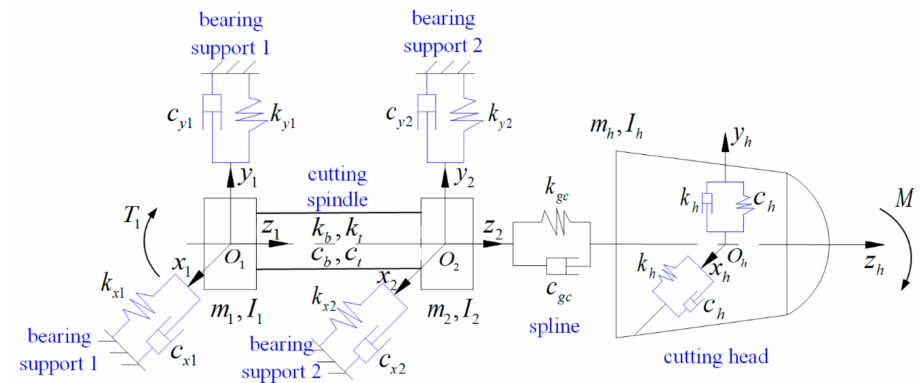
Figure 2. Structure diagram of the cutting head rotor system. The system includes the cutting spindle, bearing supports, connecting spline and cutting head. O 1 and O 2 are the origin of the coordinate system of the two concentrated masses m 1 and m 2 of the cutting spindle; O h is the origin of the coordinate system of the concentrated mass m h of the cutting head. T i is the input torque, M is the load torque of cutting head, k xi and k yi ( I = 1, 2) are the bearing support stiffness in two directions, c i ( I = 1, 2) is the bearing support damping, k b is the bending stiffness of cutting spindle, c b is the bending damping of cutting spindle, k t is the torsional stiffness of cutting spindle, c t is torsional damping of cutting spindle, k gc is the torsional stiffness of the spline between the cutting spindle and the cutting head, c gc is the torsional damping of the spline between the cutting spindle and the cutting head, k h is the bending stiffness of the cutting head, c h is the bending damping of the cutting head.